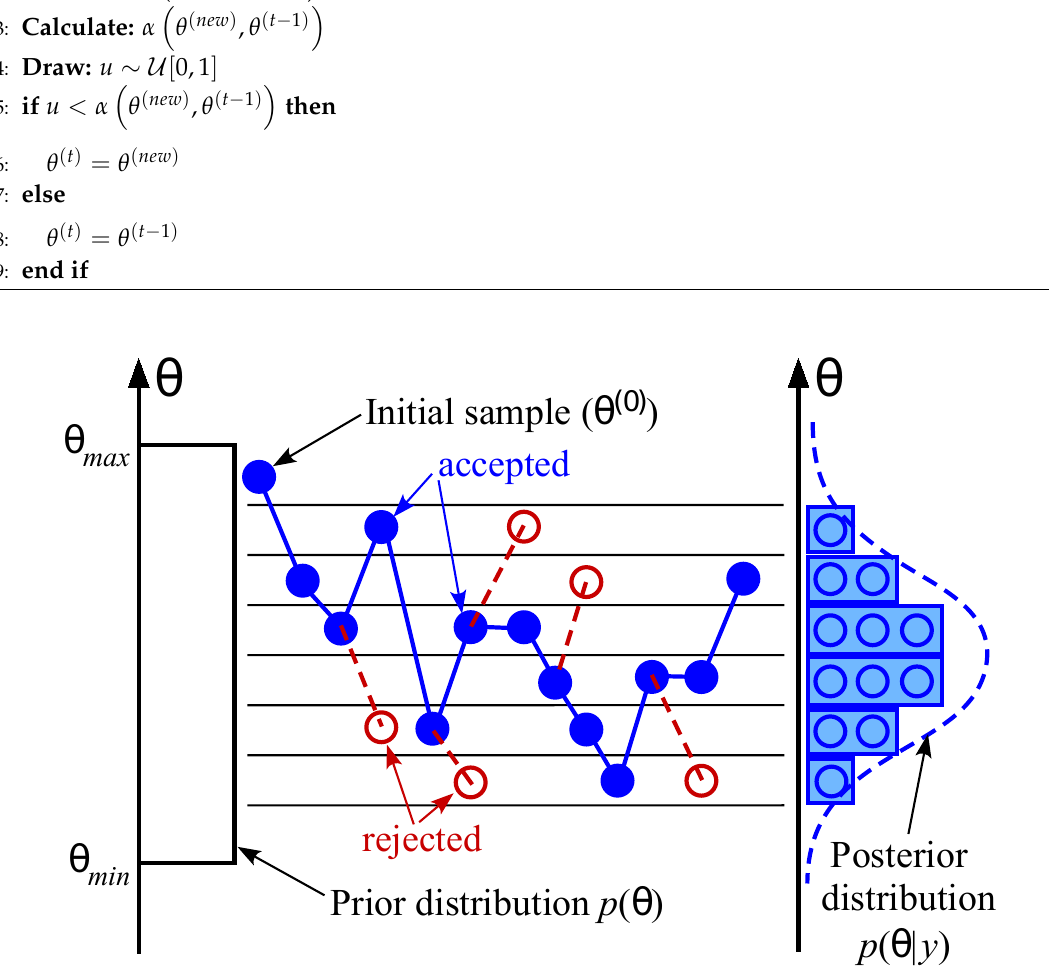
Figure 9. Illustration of the Markov chain Monte Carlo with Metropolis-Hastings (MCMC-MH)